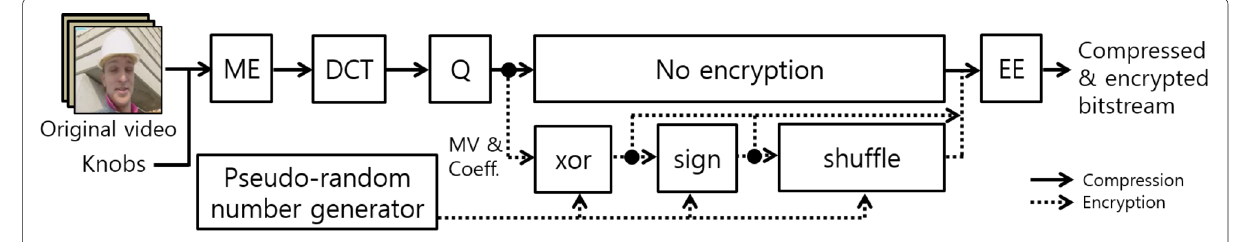
Fig. 1 Overall process of Joint Video Compression and Encryption (JVCE) exploiting the standard video codec and several encryption modules. This shows the overview of the joint compression and encryption process that has been implemented and utilized through the entire paper. Several encryption methods from previous works can be applied to the intermediate data such as coefficients during the standard video compression